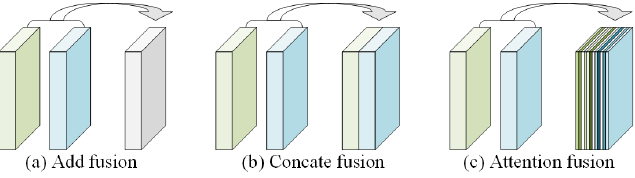
Figure 5. Comparison of different feature fusion methods. ( a ) Addition fusion. ( b ) Concatenation fusion. ( c ) Channel attention fusion.